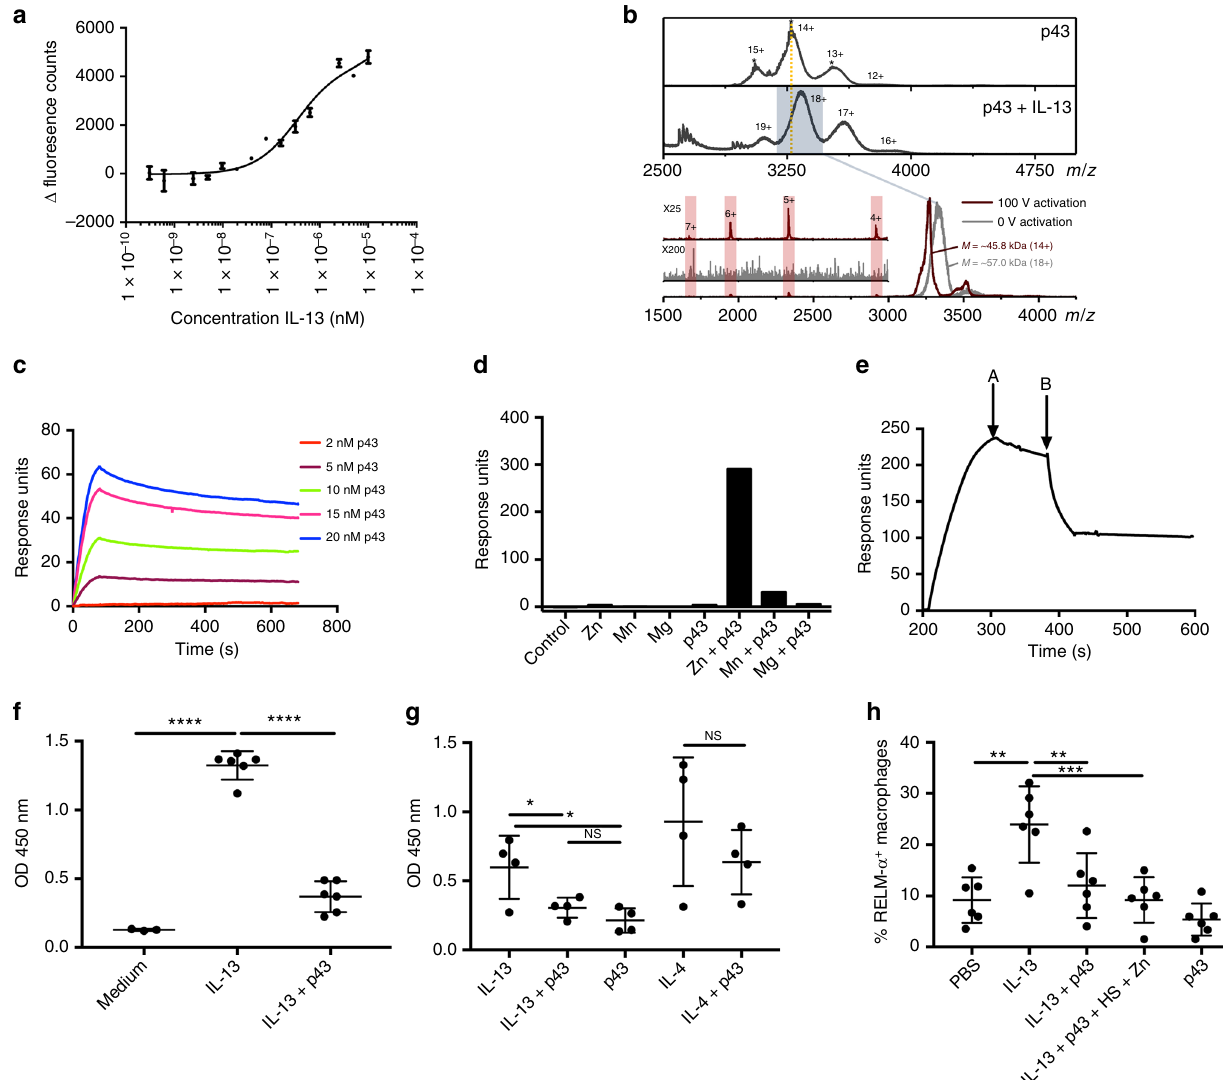
Fig. 3 p43 binds to interleukin-13 (IL-13) and the extracellular matrix in vitro. In vivo, p43 downregulates IL-13-induced in fl ammation. a Microscale thermophoresis (MST) of IL-13 binding to NHS-647-labeled p43. The results are the mean of three separate analyses±standard deviation. b Mass spectrum of p43 presenting with a narrow charge state distribution (12 – 15 + ) of heterogenous peaks centering on the 14 + charge state, upper panel. Mass spectrum of the p43:IL-13 complex is shifted to higher masses, middle panel. Collision-induced dissociation (CID) experiments were carried out on the mass-selected 18 + charge state of the p43:IL-13 complex. Under “ soft ” tuning conditions (gray trace), the 18 + charge state gave a broad peak ( m / z of 3328). At a trap collision energy of 100V, which promotes gas-phase protein activation (red trace), the p43:IL-13 mass selected peak shifts to a lower m / z ( m / z 3260). The associated loss of mass of the p43:IL-13 18 + ion corresponds to the dissociation of a single IL-13 molecule (11.7kDa). Inset peaks corresponding to the 4 – 7 + charge states of IL-13 at a collision energy of 100V, which were not present at 0V, lower panels. c Surface plasmon resonance (SPR) of biotinylated heparan sulfate (HS) and increasing amounts of p43. d SPR showing zinc-dependent binding of biotinylated HS with p43. e SPR of biotinylated HS binding to p43 with IL-13 competition (A, p43 injection stops B, IL-13 injected). All in vitro experiments from a to e were repeated at least 3 times and a representative experiment has been shown. f , g Resistin-like molecule- α (RELM- α ) produced by peritoneal exudate cells (PECs) after in vitro stimulation by IL-13±p43 or IL-4±p43 measured by enzyme-linked immunosorbent assay (ELISA). f Six technical replicates from two pooled mice, p = 204.6, DF = 12, **** p <0.0001. g RELM- α from four individual mice. Analysis by one-way analysis of variance (ANOVA), p = 7.422, DF = 9, IL-13 vs. IL-13 ±p43, * p = 0.0489. h Percentage of RELM- α -positive interstitial lung macrophages from six individual C57BL/6 mice given administration of IL-13±p43 to the respiratory tract. Data are from two experiments, n = 6 individual C57BL/6 mice. Bars denote means±SEM. Analysis by one-way ANOVA; the data passed the Shapiro – Wilk and KS normality tests, p = 10.38, DF = 25, IL-13 vs. IL-13±p43, ** p = 0.0063, IL-13 vs. IL-13±p43 + HS + Zn, *** p =